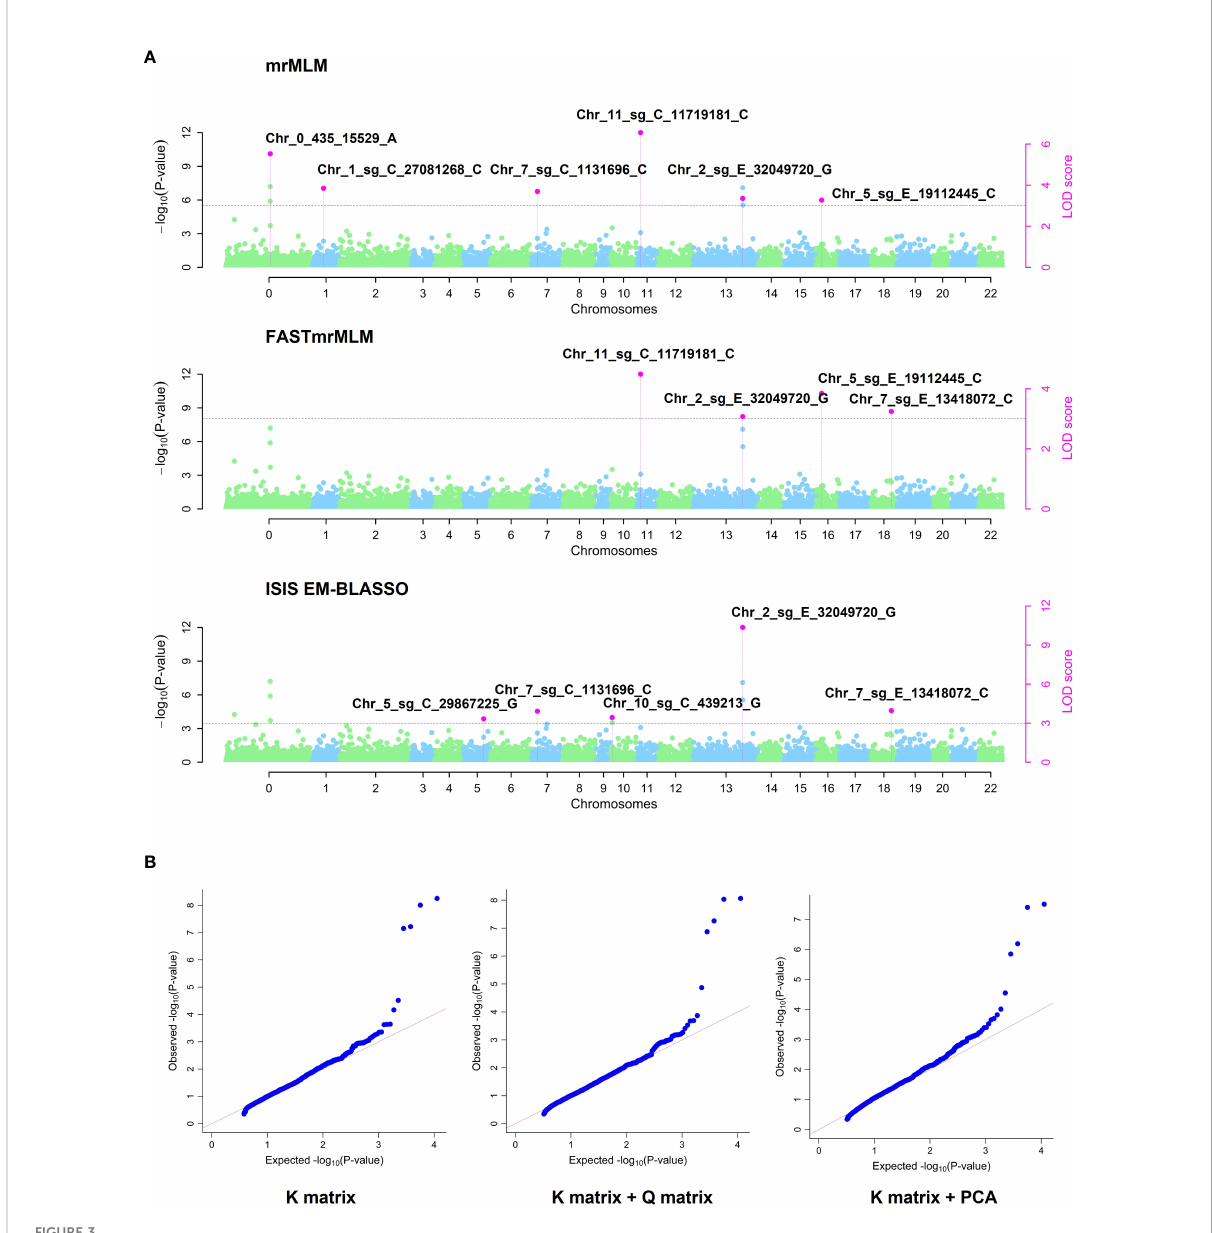
FIGURE 3 Multi-locus GWAS. (A) Manhattan plots corresponding to mrMLM, FASTmrMLM, and ISIS EM-BLASSO for C. arabica and P. syringae pv. garcae interaction. The manhattan plots indicate the -log10 (p-value) and the LOD score of SNP across the genome (y-axis) plotted against their respective position on each chromosome (x-axis). The chromosome (Chr) zero correspond to scaffolds that did not have a de fi ned position during the genome assembly, Chr 1 to 11 correspond canephora subgenome, Chr 12 to 22 correspond to eugenioides subgenome. (B) Q-Q plots from multi-locus models adjusted by different population structure approaches. Kinship matrix (K matrix), principal component analysis (PCA), and the population structure K = 2 identi fi ed from software STRUCTURE (Q